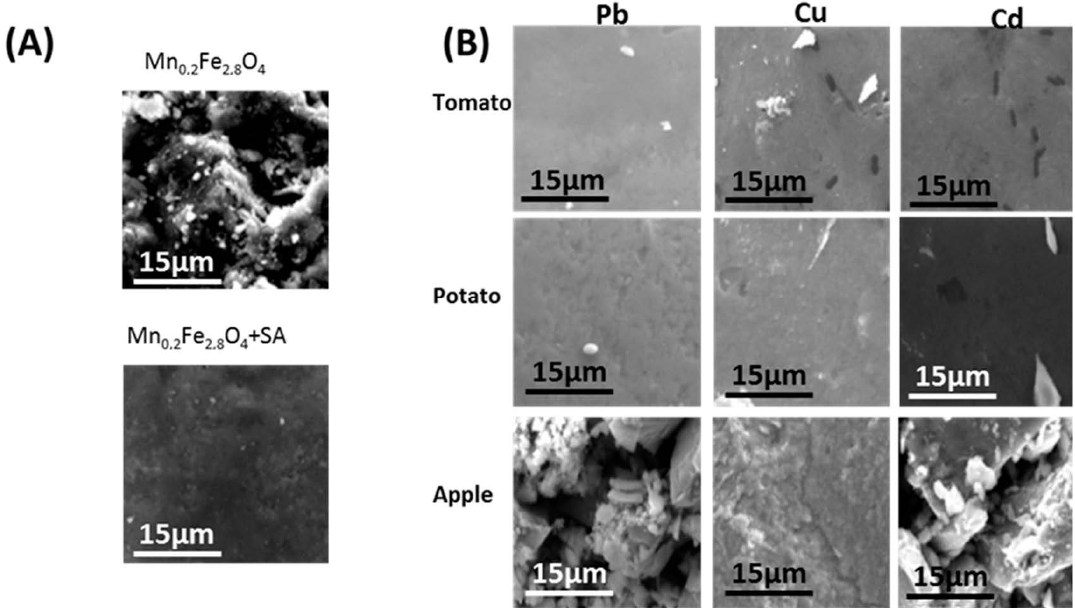
Figure 3. SEM images of films of ( A ) pristine Mn-doped ferrite nanoparticles; ( B ) nanoparticles after detection tests of heavy metals in selected food samples.